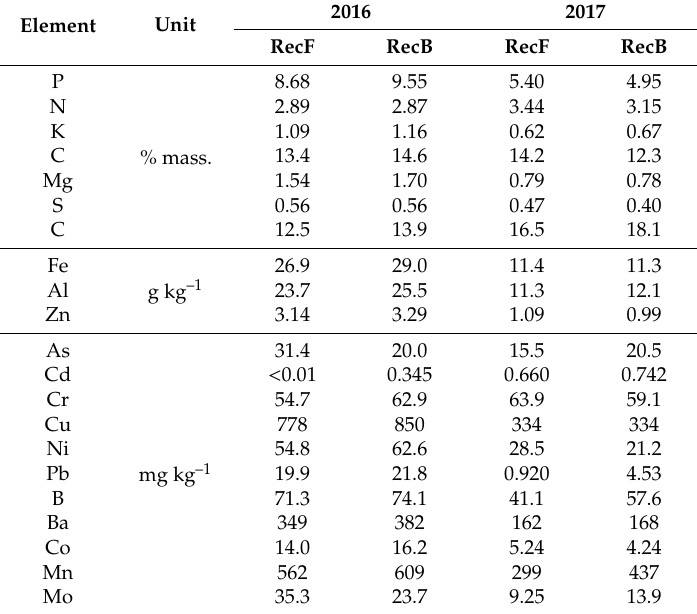
Table 1. Elemental composition of the recycled fertilizers.